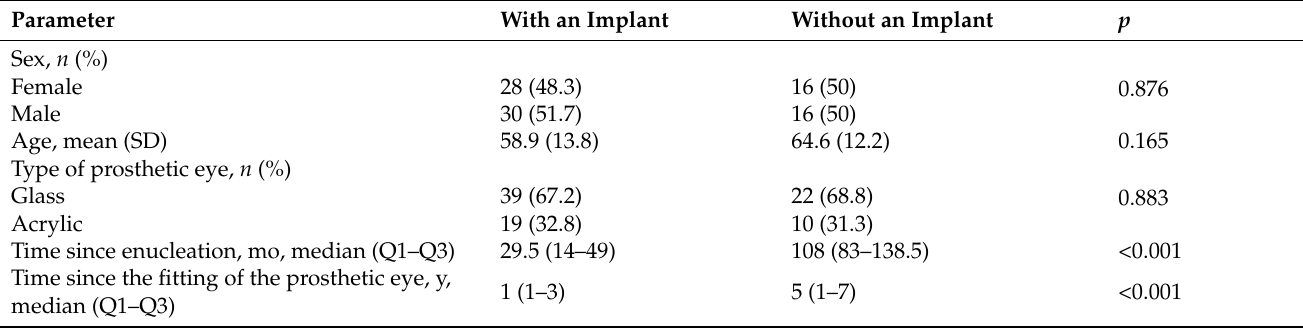
Table 1. Characteristics of patients after enucleation with and without an orbital implant.